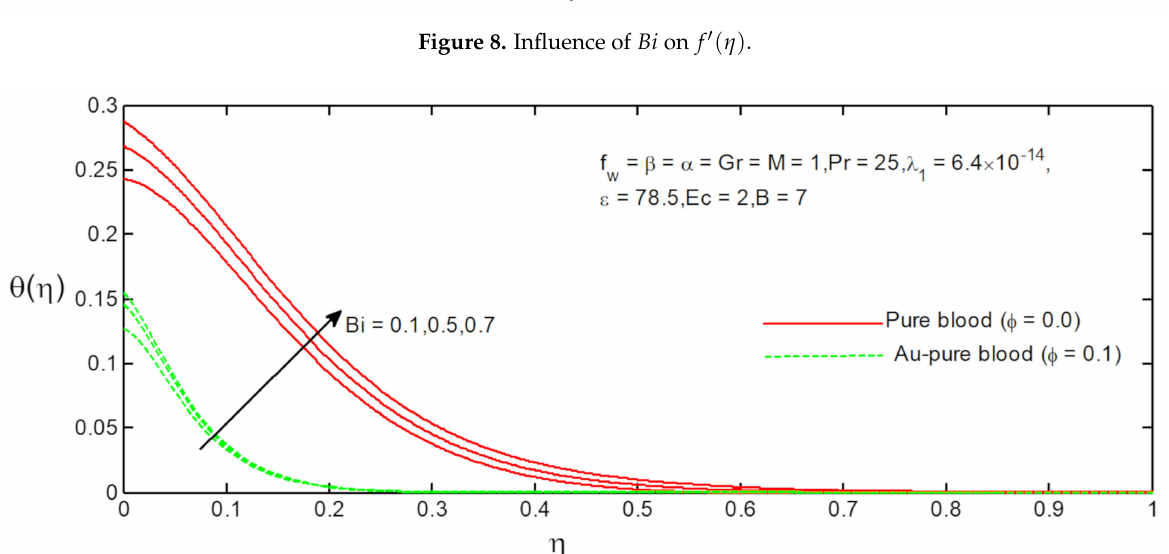
Figure 9. Influence of Bi on θ ( η )